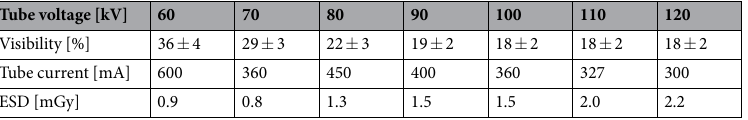
Table 2. Image acquisition parameters. At every tube voltage one image was acquired. All seven scans were acquired in a time span of 40 min. During each scan, every part of the field of view received 25 × -ray pulses of 20 each. Visibility is given as mean ± standard deviation across the field of view. ESD: entrance surface dose measured at source distance of 152 cm (16 cm above patient